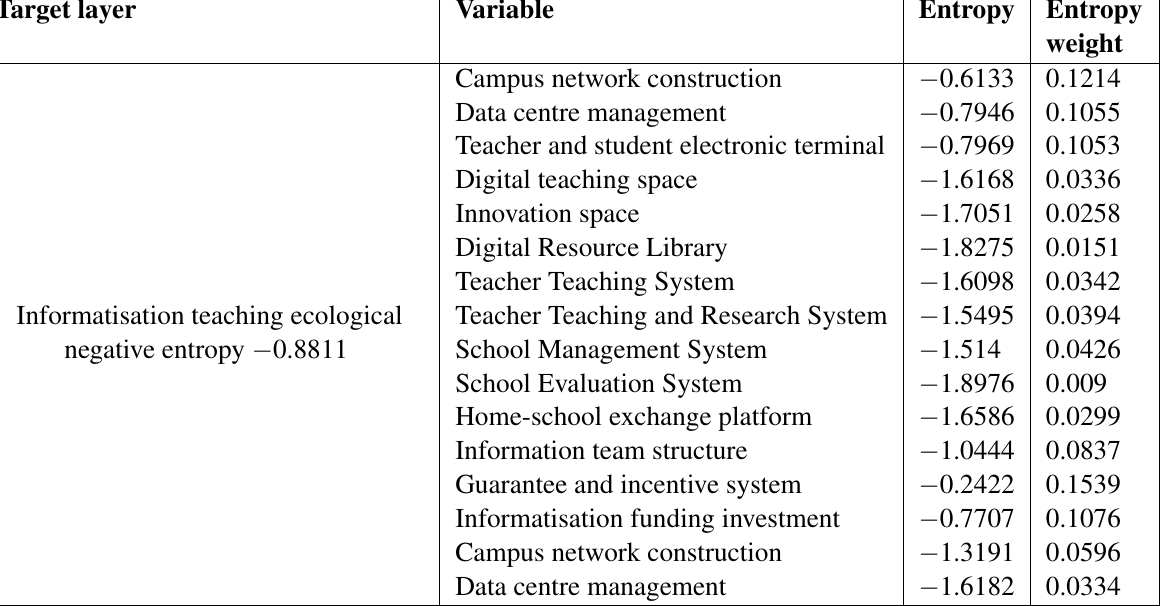
Table 2 Ecological negative entropy of informatisation